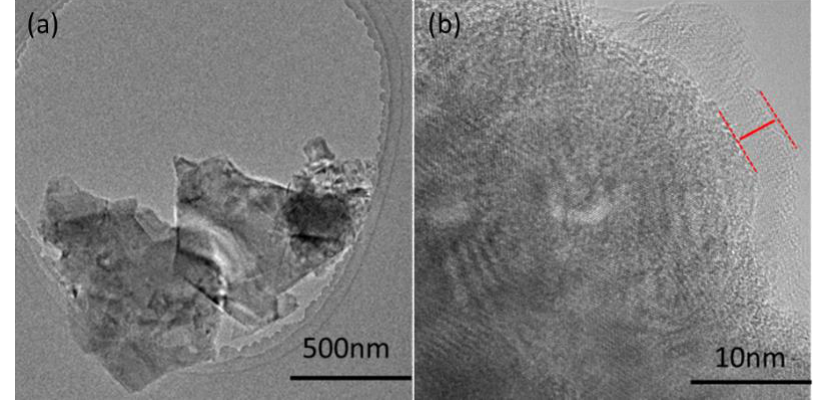
Figure 3. TEM images of ( a ) MoS 2 -APTES and ( b ) high-resolution TEM morphology of MoS 2 - APTES.